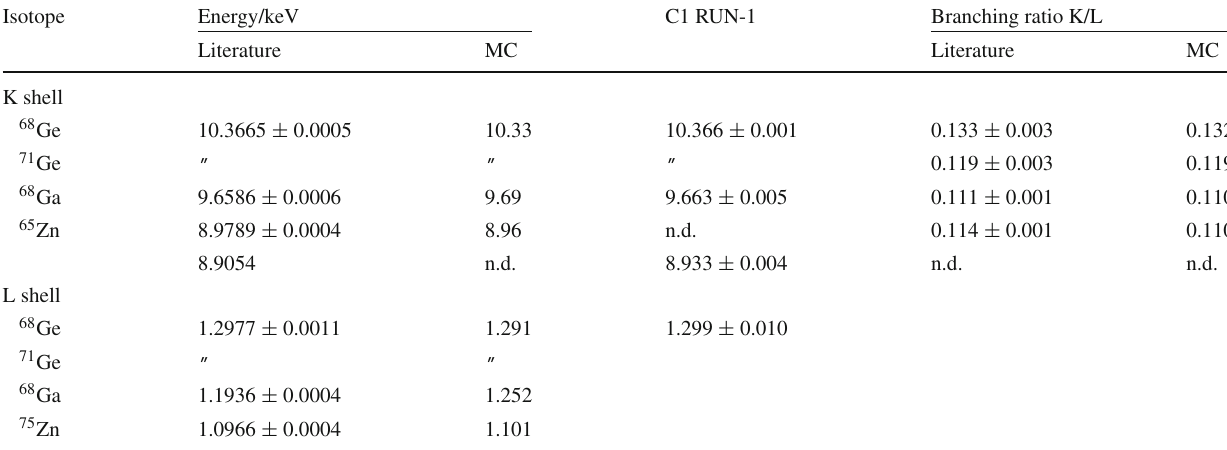
Table 4 Comparison of energies and branching ratios of the K- and L-shell lines of the isotopes clearly visible in the lowE range of the CONUS data. The energy values from the literature that are applied for the calibration of the CONUS data are taken from [37] with uncertain- ties [38], while the K- to L-shell emission ratios are derived from [39]. The energy values evaluated from the CONUS data (exemplary for C1